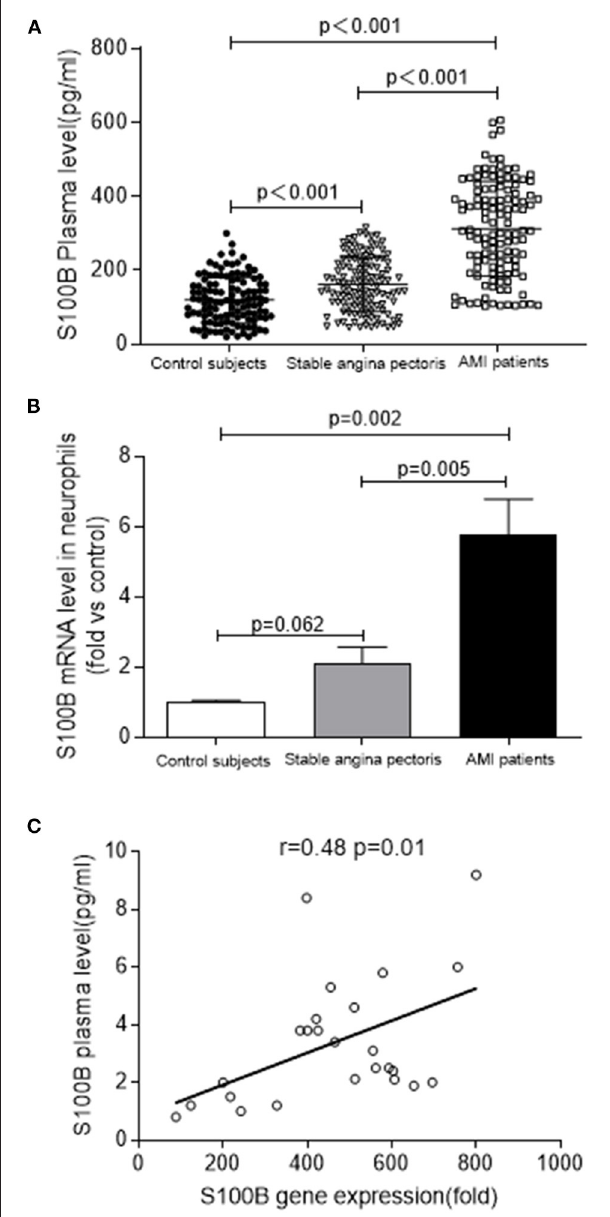
FIGURE 1 | S100B levels are increased in patients with AMI. (A) S100B plasma levels in AMI ( n = 125) and stable angina pectoris ( n = 122), as compared to those in control subjects ( n = 120). (B) S100B gene expression in the neutrophils of AMI patients ( n = 10) and stable angina pectoris patients ( n = 10) as compared to those in control subjects ( n = 10). (C) Correlation between S100B gene levels in the neutrophils and plasma S100B of AMI